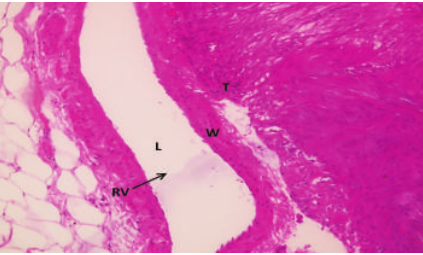
Figure 4: The relationship between tumoural tissue and renal vein (T: tumor, RV: renal vein, L: lumen, and W: wall; H&E × 40).